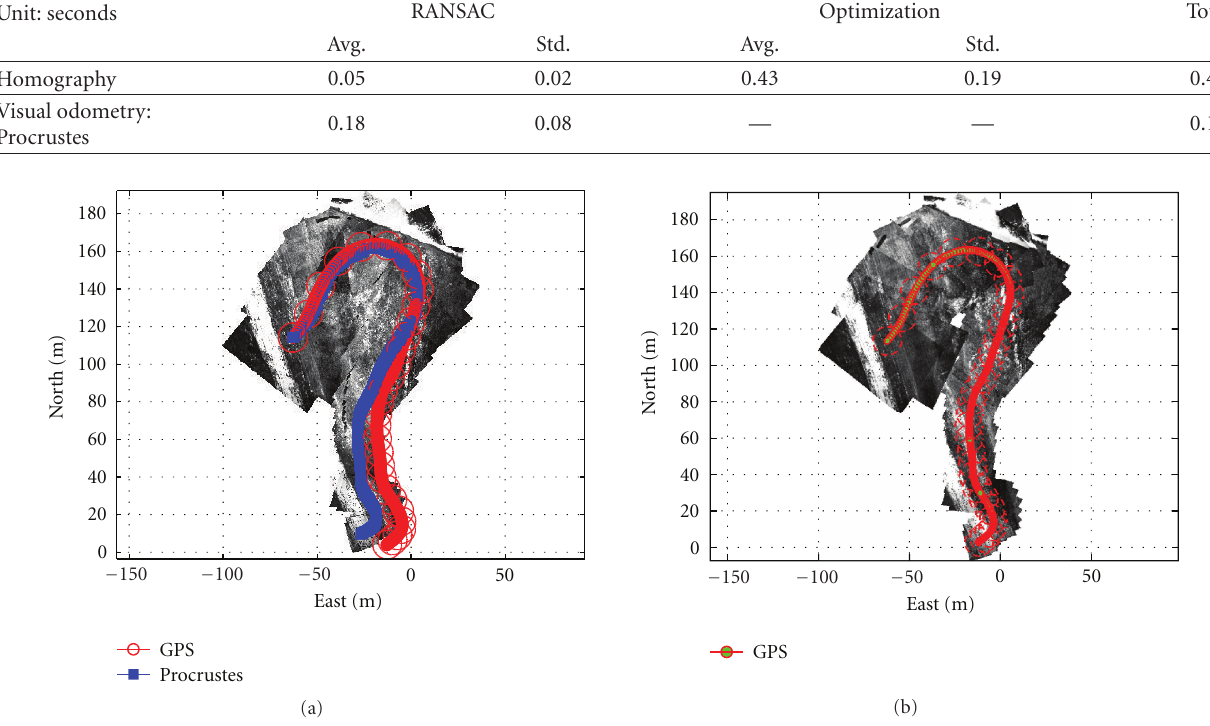
Figure 9: Maps formed by reprojecting the images on the ground plane, with trajectories superimposed. The circles indicate some of the GPS eph values (i.e., one standard deviation).